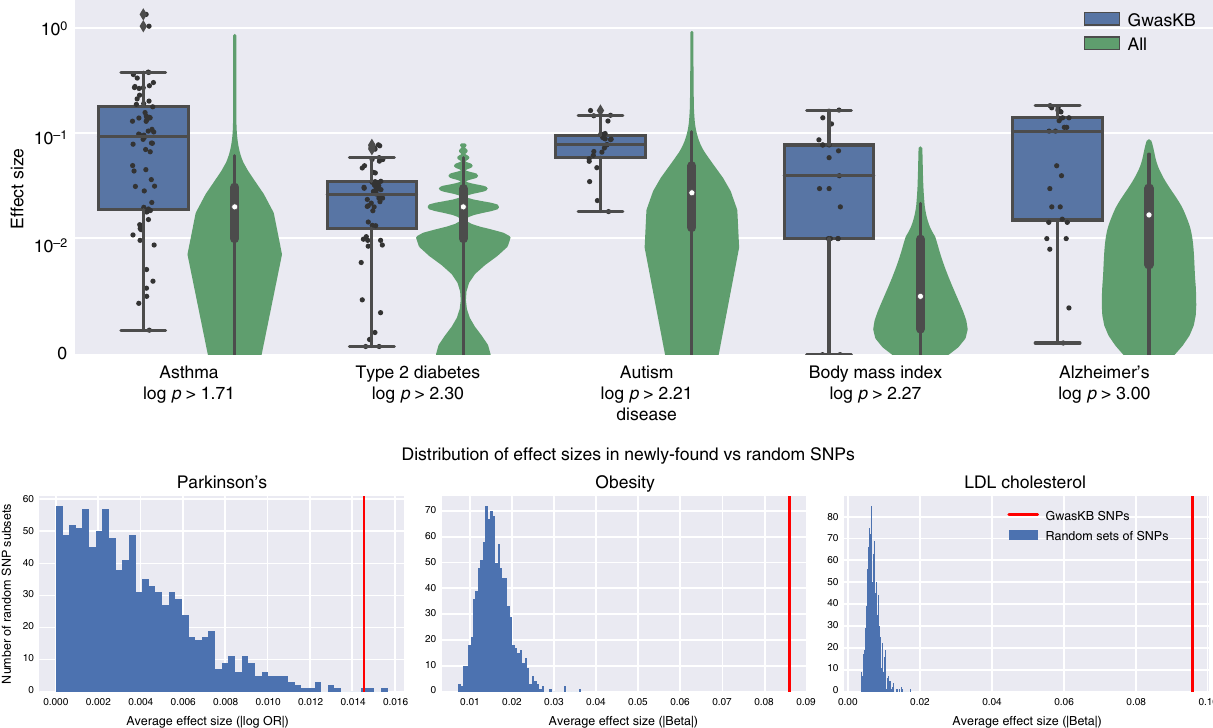
Fig. 4 Visualizing the effect sizes of variants identi fi ed in GWASkb. Top: We compare the distribution of effect sizes (absolute values of beta coef fi cients or log odds ratios; data from LD Hub) of variants identi fi ed in GWASkb (blue) to that of all variants (green) for multiple traits. Blue variant effect sizes cluster away from zero and follow a different distribution (Kolmogorov – Smirnov test). In the boxplots, center lines represent medians, the box boundaries span the interquartile range, and the whiskers extend to the minimum and maximum observations excluding statistical outliers. Bottom: We subsample 1000 random sets of variants with the same number of elements as the set of GWASkb SNPs for a given disease; the average effect size of GWASkb variants (red) is higher than that of the random subsets (blue). In all settings, we only look at novel GWASkb variants not present in existing